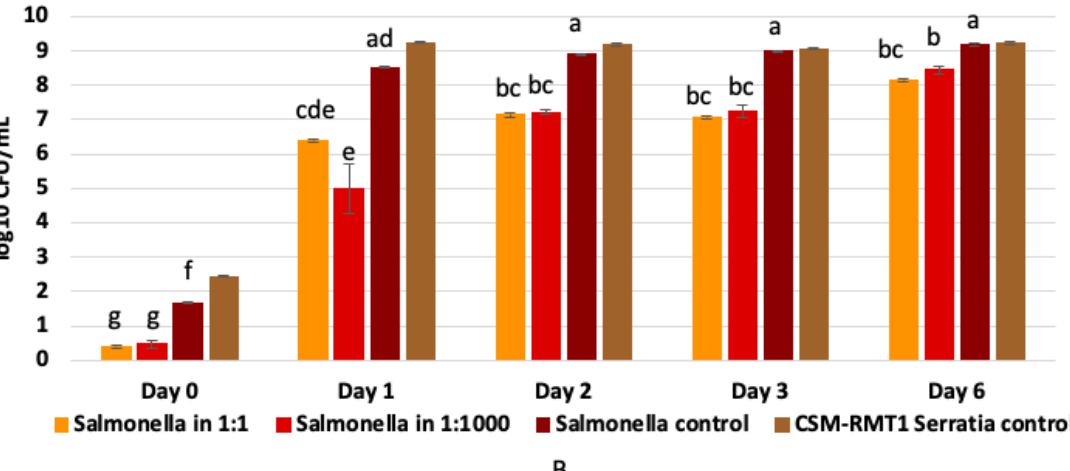
Figure 4. Co-culturing results of prodigiosin-negative S. marcescens CSM-RMT-1 and Sa. enterica in ( A ) TS broth and ( B ) 2.8% fat-containing UHT milk after 0, 1, 2, 3 and 6 days of incubation. Different upper-case letters by CLD indicate a significant difference between the cell numbers according to Tukey ’s HSD post hoc tests ( α = 0 .05).